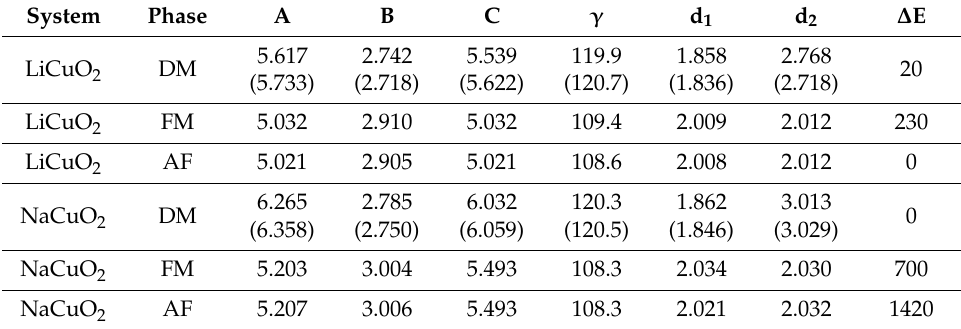
Table 2. Experimental (in parenthesis) and calculated by DFT B1WC lattice parameters A, B, C (in Å), lattice angle γ (degrees), interatomic equatorial d 1 (Cu-O eq ) and axial d 2 (Cu-O ax ) distances in the diamagnetic (DM), ferromagnetic (FM), and antiferromagnetic (AF) phases of LiCuO 2 and NaCuO 2 and their relative energies ∆ E (in cm − 1 ). Reproduced with permission from